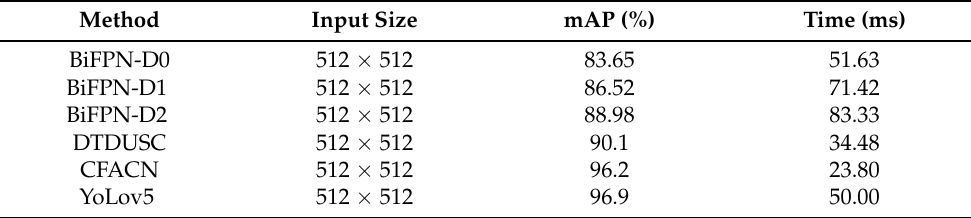
Table 4. The mean average precision and computational time of four different detectors. DTDUSC: Deep learning-based strategy to detect and track drones using several cameras.